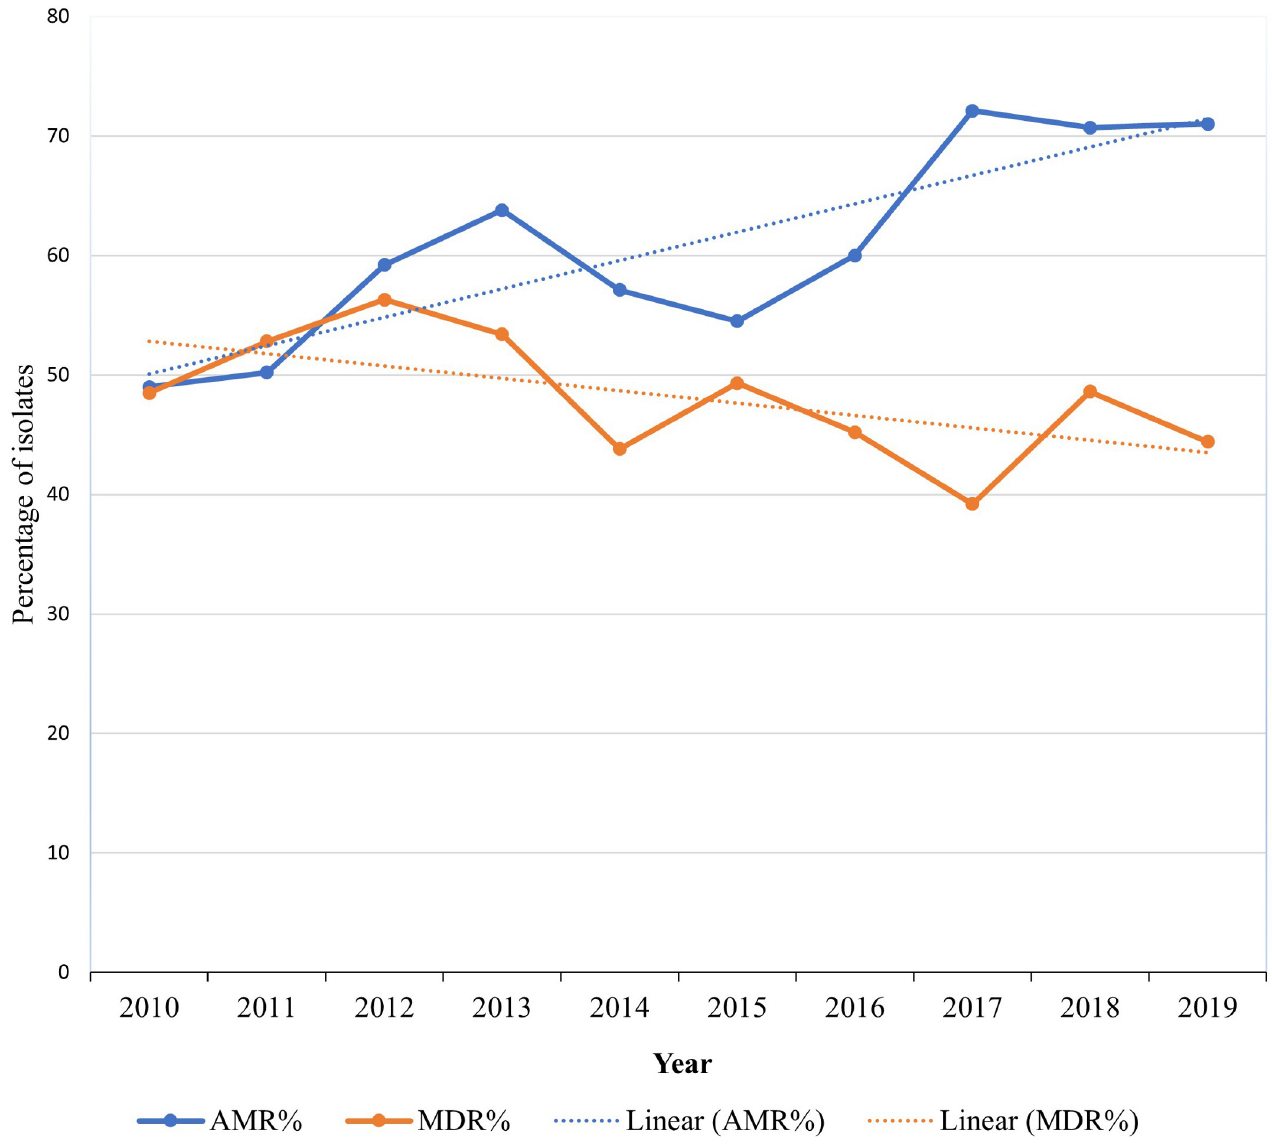
Fig 1. A graphical representation of the temporal trends in antimicrobial resistance and multidrug resistance among Escherichia coli isolated from dog specimens at the Indiana Animal Disease Diagnostic Laboratory, 2010–2019.